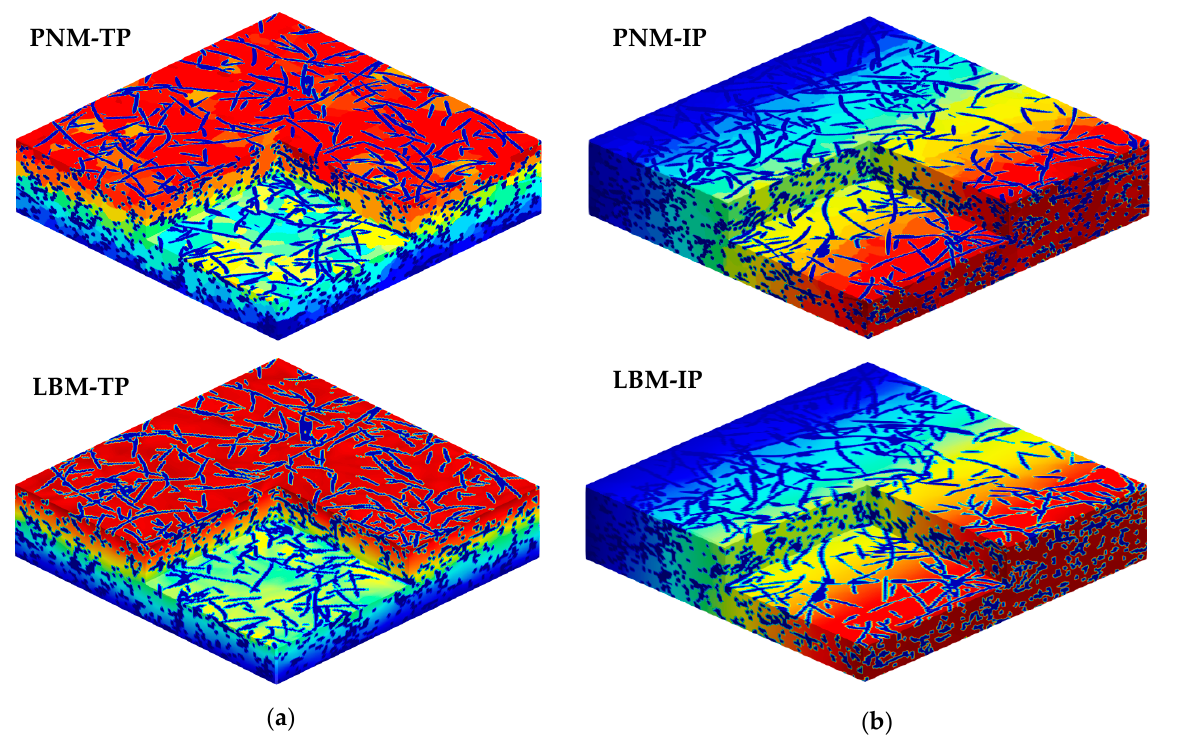
Figure 7. Concentration distribution of the 68% porosity PMFSS in left ( a ) TP and right ( b ) IP directions using PNM (top) and LBM (bottom) methods.